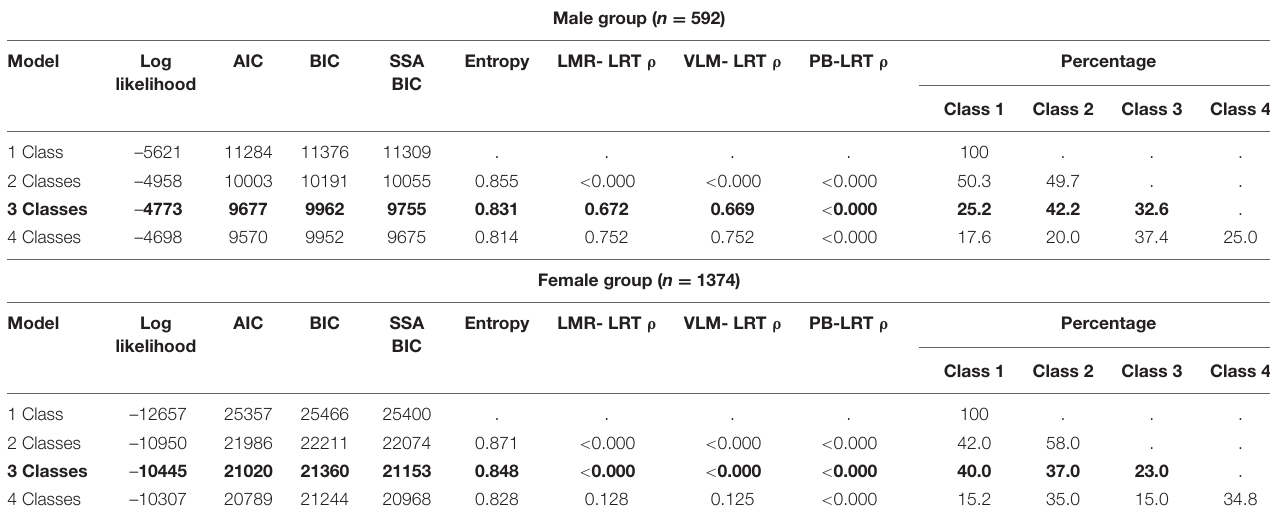
TABLE 5 | Latent class solution model fit indices using the symptoms of anxiety (GAD-7) for the male and female groups separately. Male group ( n =